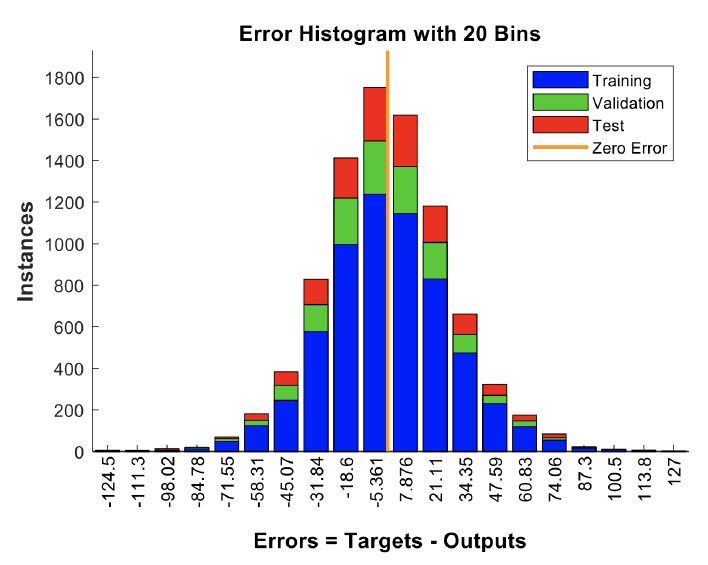
Figure 9. The error histogram of the load forecast